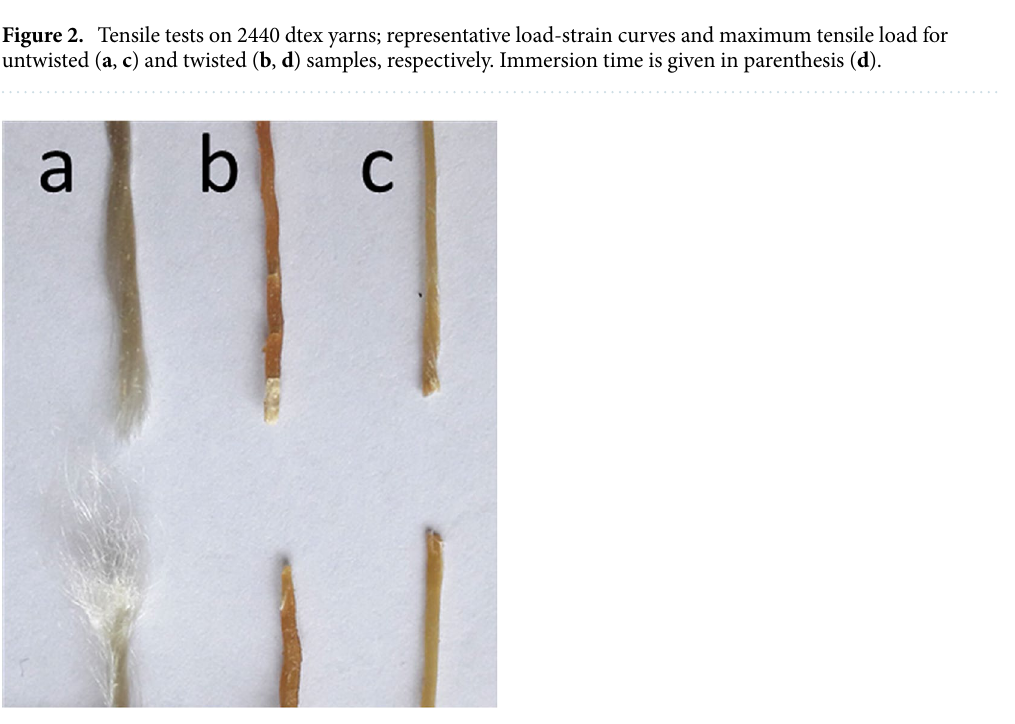
Figure 3. Characteristic fracture pattern of 2440dtex twisted yarn; untreated ( a ), isocyanate hardener ( b ) and pMDI ( c )